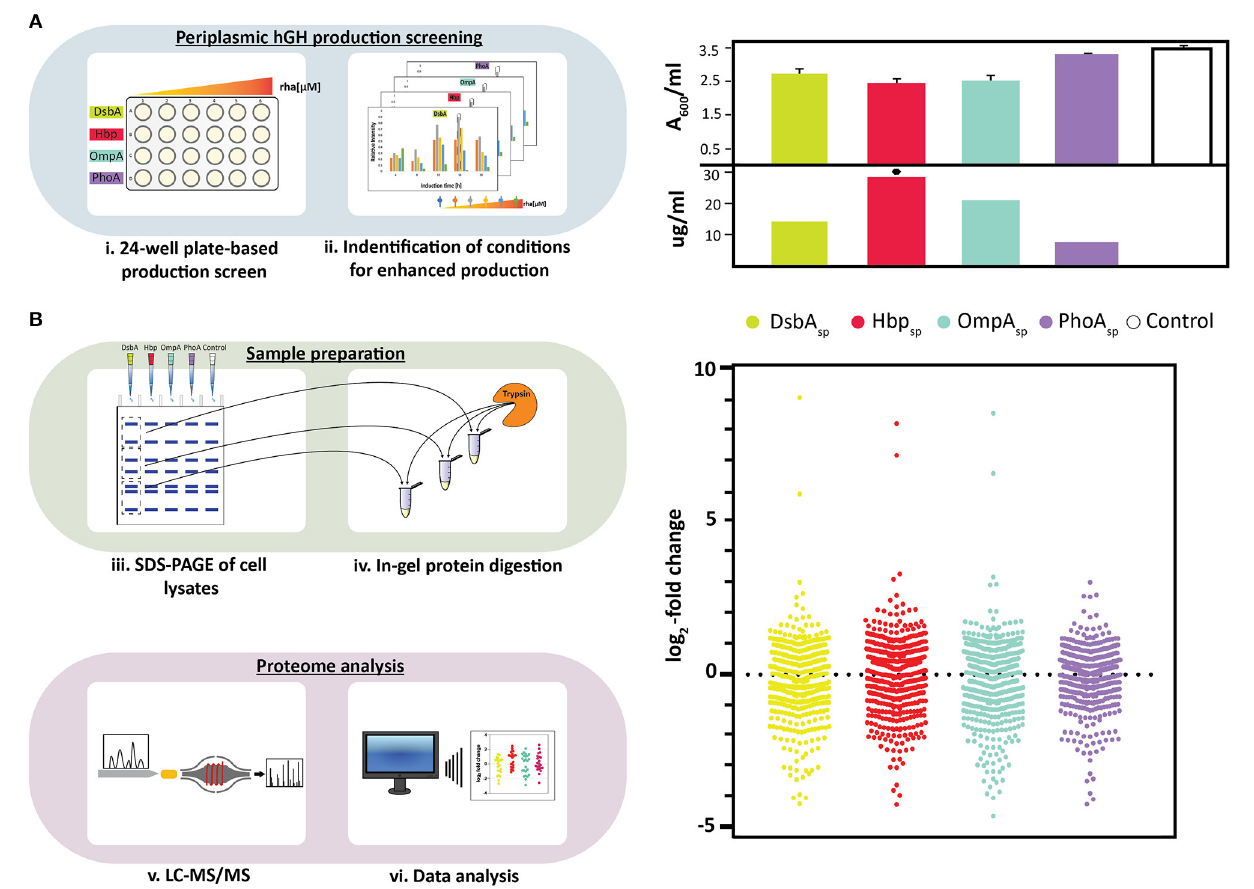
FIGURE 1 | Periplasmic hGH production screening and proteome analysis of hGH producing cells. (A) On the left: Periplasmic production screening of hGH fused to different signal peptides (DsbA sp , Hbp sp , OmpA sp , and PhoA sp ) was done in standard 24-well plates (i). Expression of the hgh gene fused to the genetic information encoding the four different signal peptides was induced using varying amounts of rhamnose. The production of hGH in the periplasm was monitored over time by separating proteins present in equal volumes of culture by SDS-PAGE followed by immuno-blotting using a fluorescently labeled antibody recognizing the C-terminal His 6 -tag of hGH. This enabled to make for each of the signal peptides used a relative comparison of the hGH production yields in the periplasm (ii). On the right: For each signal peptide used, both biomass formation (A 600 , based on three independent biological replicates) and periplasmic hGH production ( µ g of hGH produced per ml of culture) were determined for the setup leading to the highest periplasmic hGH production yield per culture volume (see Materials and Methods). The highest volumetric periplasmic hGH production yield is indicated with a black hexagon. (B) On the left: Proteins in whole cell lysates were separated by SDS-PAGE (iii). A whole cell lysate derived of cells with an empty expression vector, i.e., not producing any hGH, were used as a reference. Proteins present in different sections of the gel were digested using trypsin (iv) and the digested material was subsequently analyzed by LC-MS/MS (v). Relative quantification of identified proteins was done using the label free quantification (LFQ) algorithm (vi). On the right: Relative abundance of proteins in whole cell lysates derived of cells producing hGH in the periplasm employing DsbA sp , Hbp sp , OmpA sp , and PhoA sp using whole cell lysates derived of cells with an empty expression vector as a reference. Distribution of changes in the relative abundance of proteins are shown in a vertical scatter plot; log 2 -fold changes that are statistically significant ( p < 0.01, ANOVA, Supplementary Table 1 ) were plotted using GraphPad Prism as a Column